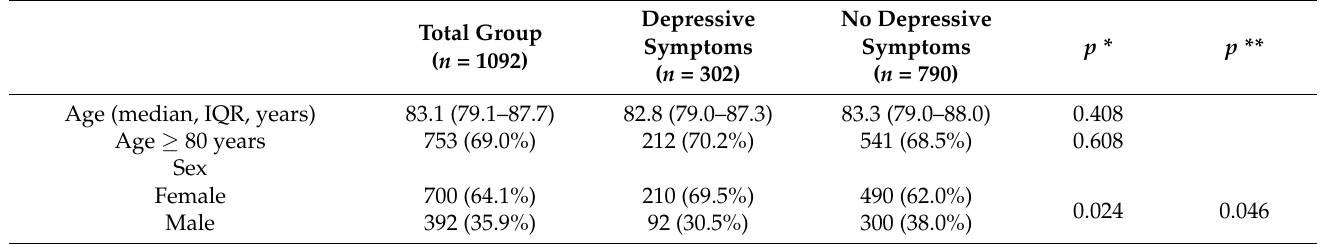
Table 3. Elderly patients with and without depressive symptoms treated in a structured geriatric setting (comprehensive geriatric